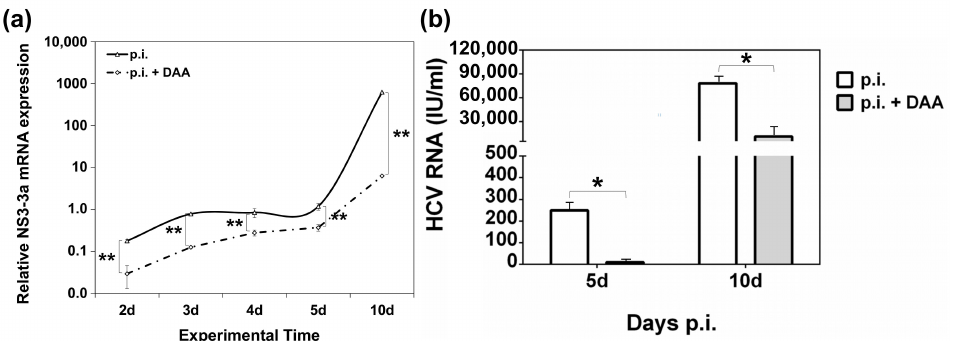
Figure 4. ( a ) HCV-3a replication levels before and after HCV eradication in an in vitro HCV clearance model. Huh7.5 hepatoma cells were infected with HCV-3a and treated with a mixture of HCV antiviral compounds (DAA) or left untreated. The infected cells were harvested at the stated time points p.i. and subjected to RT-qPCR with NS3-3a-specific oligonucleotide primers as an indicator of HCV replication in the presence (continuous line) and absence (dotted line) of the antiviral treatment. Relative mRNA expression for the HCV NS3-3a gene is plotted on a logarithmic axis. Statistically significant differences between the HCV NS3-3a mRNA values from DAA-treated and untreated infected cells are denoted by one star ( p -value ≤ 0.05), or two stars ( p -value ≤ 0.005). ( b ) HCV infectivity following DAA administration in an in vitro HCV clearance model. Supernatants from the HCV-3a-infected hepatoma cell cultures described above were collected before (white bars) and after (grey bars) DAA treatment and used for the isolation of viral RNA. Statistically significant differences within groups are denoted by one star ( p -value ≤ 0.05), or two stars ( p -value ≤